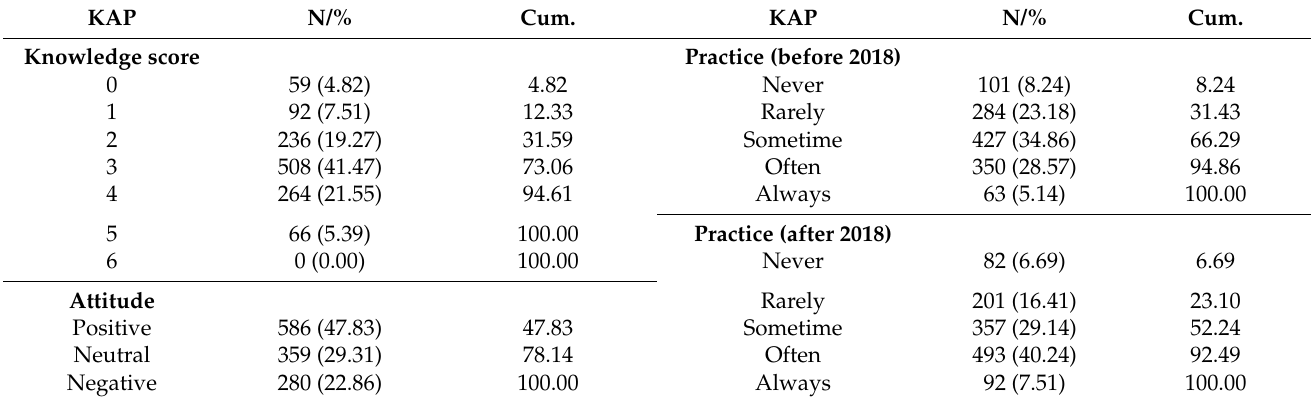
Table 2. Physician generic substitution KAP distribution in China ( n =